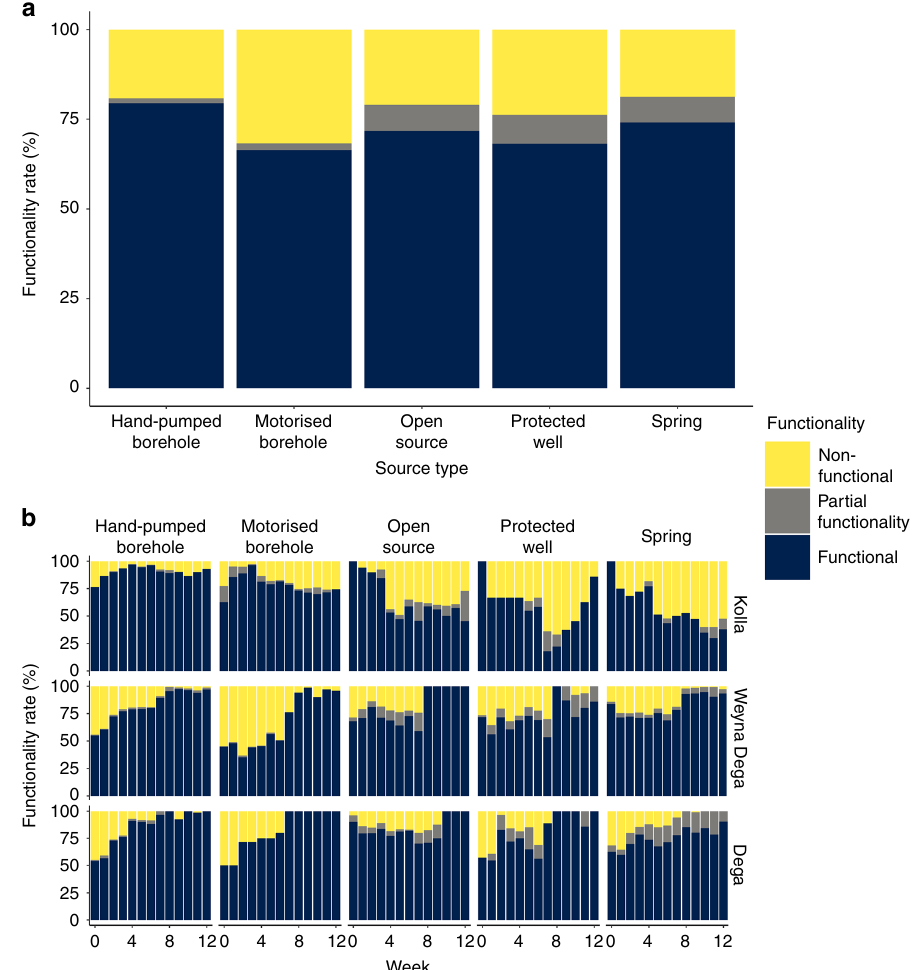
Fig. 3 Water source functionality. a Overall functionality of each water source type during the drought. Supplementary Figure 2 shows the number of site visits and for which functionality data are available. b Weekly functionality rates of each water source type in the Ethiopia ’ s three altitude zones. Supplementary Figure 5 provides details on the numbers of each source type visited in each altitude zone and for which functionality data are